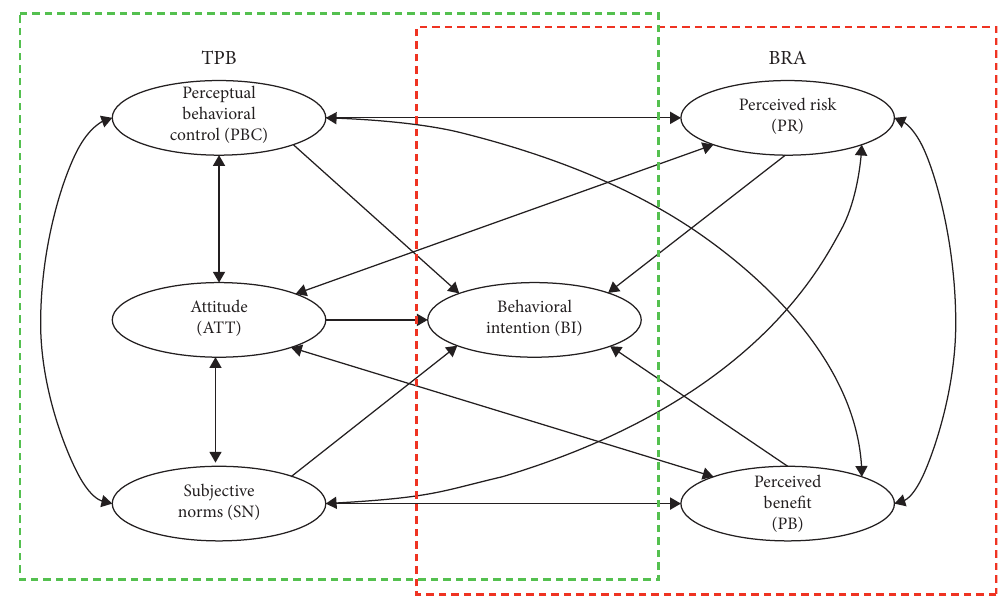
Figure 3: Mixed theoretical framework for this